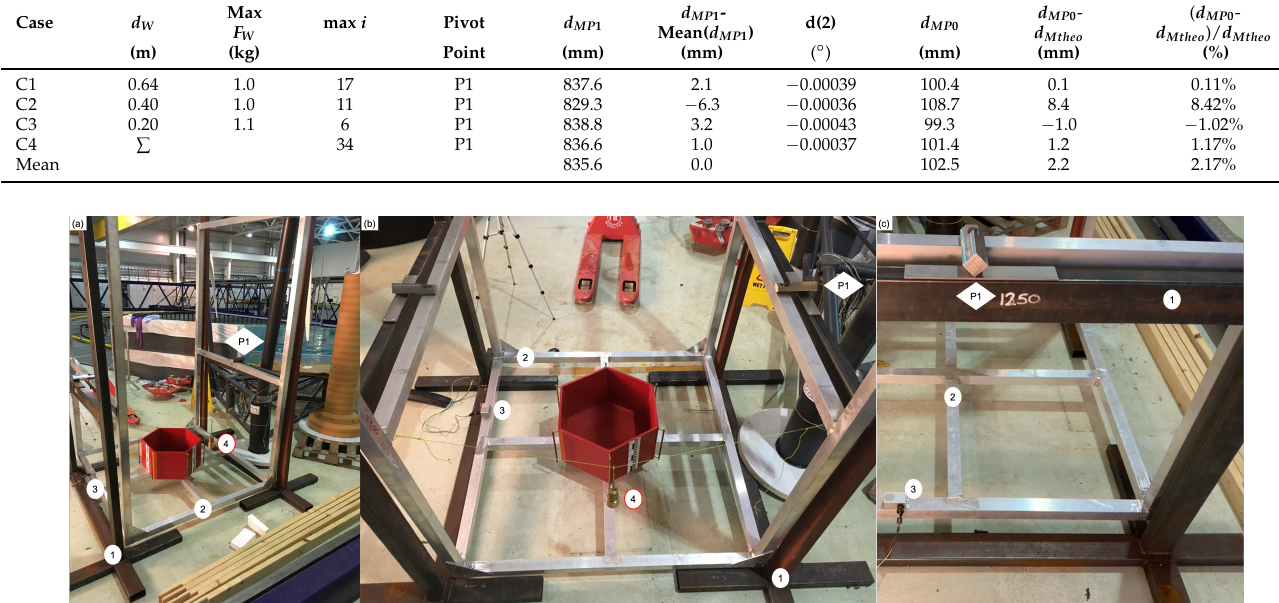
Figure 8. Example model on the swing with support structure (1), swing (2), inclinometer (3) and calibration weights including the rope highlighted with a red line (4) as well as the used pivot axis P1: ( a ) overview, ( b ) detail from the back of the swing ( c ) and the knife edge